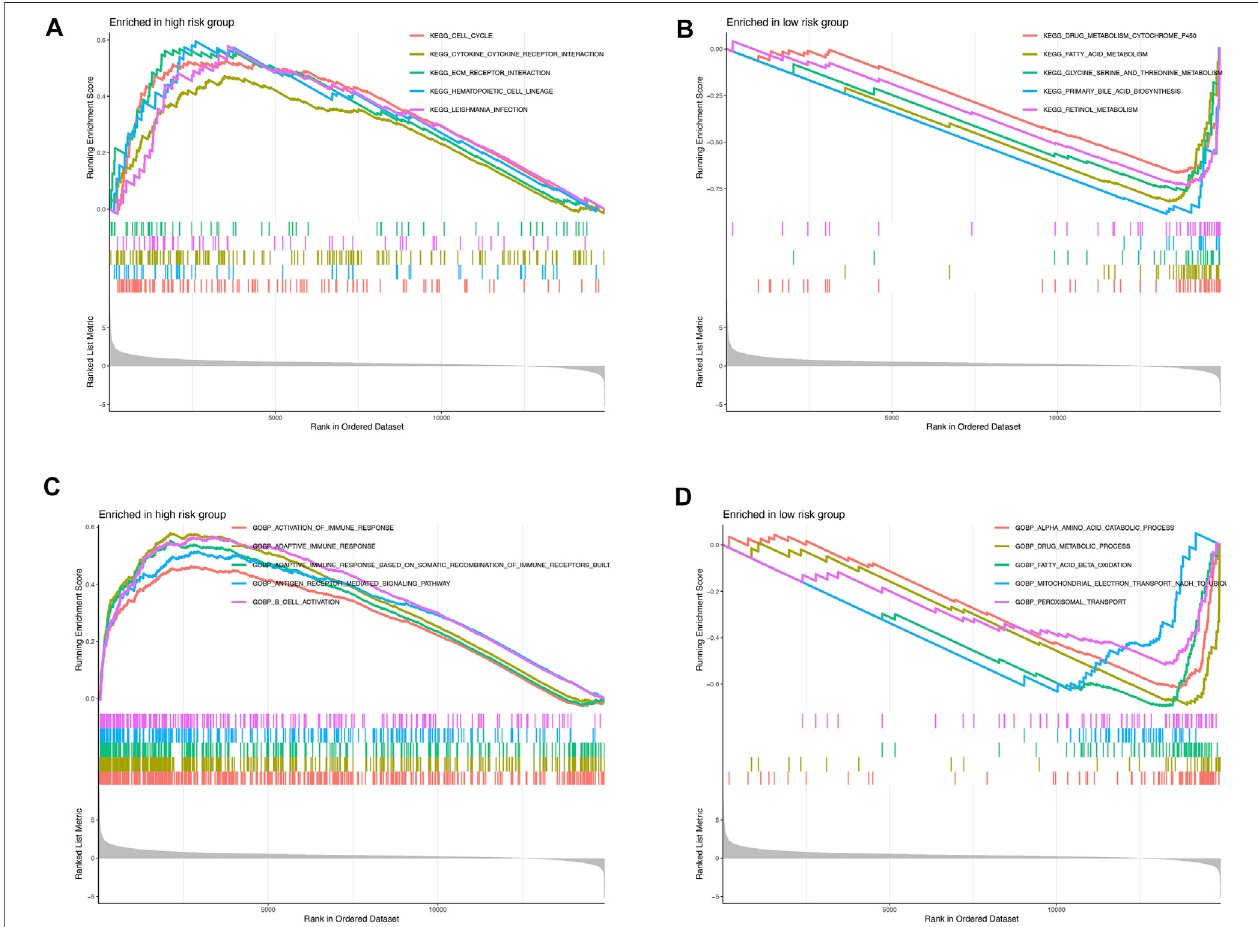
FIGURE6| Enrichmentplotsfromgenesetenrichmentanalysisinthehigh-andlow-riskgroups (A,B) KEGGenrichmentanalyses; (C,D) GObiologicalprocesses enrichment analyses.